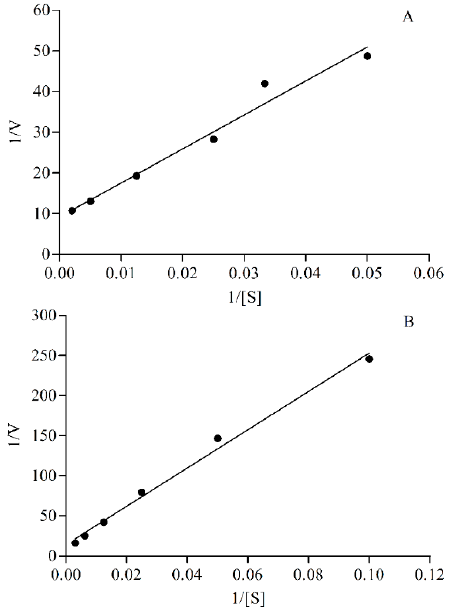
Figure 3. Lineweaver-Burk plot of 4-nitrocatechol ( A ) and 6 β -hydroxytestosterone ( B ).